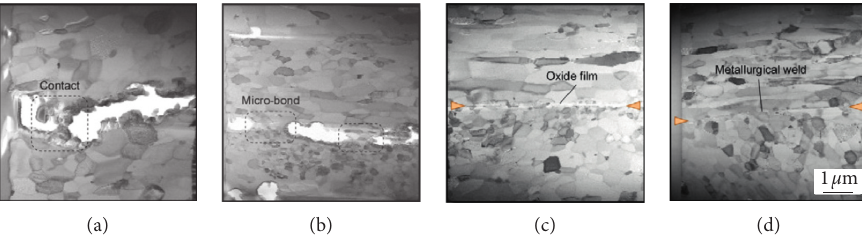
Figure 5: Bright-field TEM images of (a) unbonded region, (b) partially bonded region, (c) bonded region with residual oxide film, and (d) completely bonded region [47].